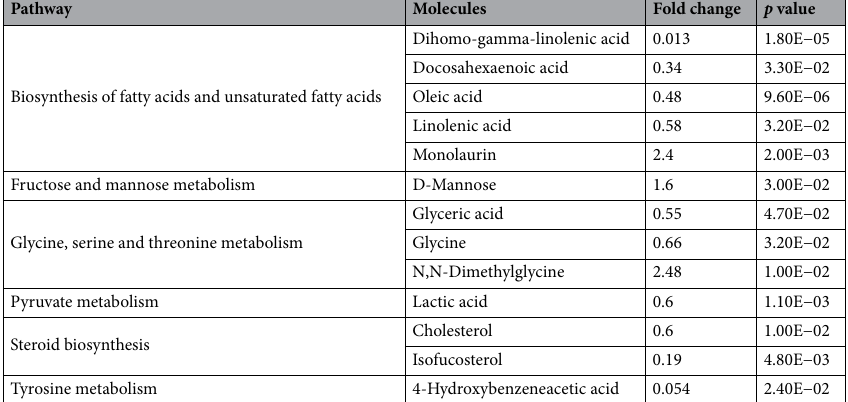
Pathway Molecules Fold change p